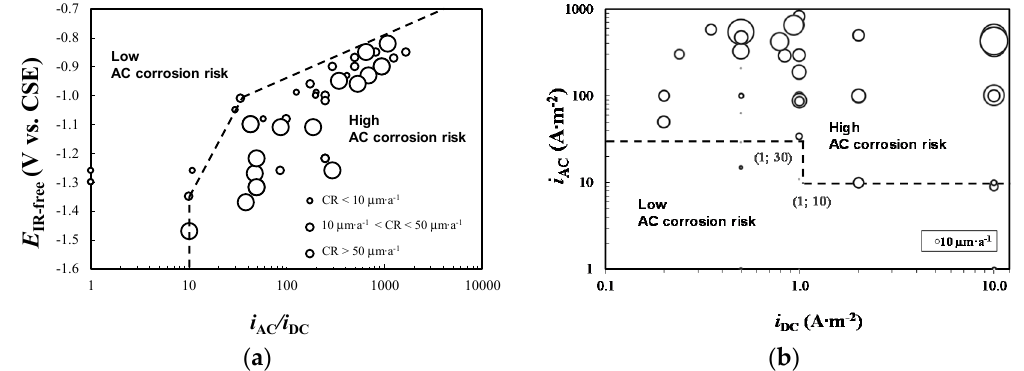
Figure 6. AC corrosion protection criterion as proposed by Ormellese et al.: ( a ) AC corrosion risk diagram based on IR-free potential and current densities ratio, ( b ) protection criterion based on AC and DC (i.e., cathodic protection—CP) current densities.